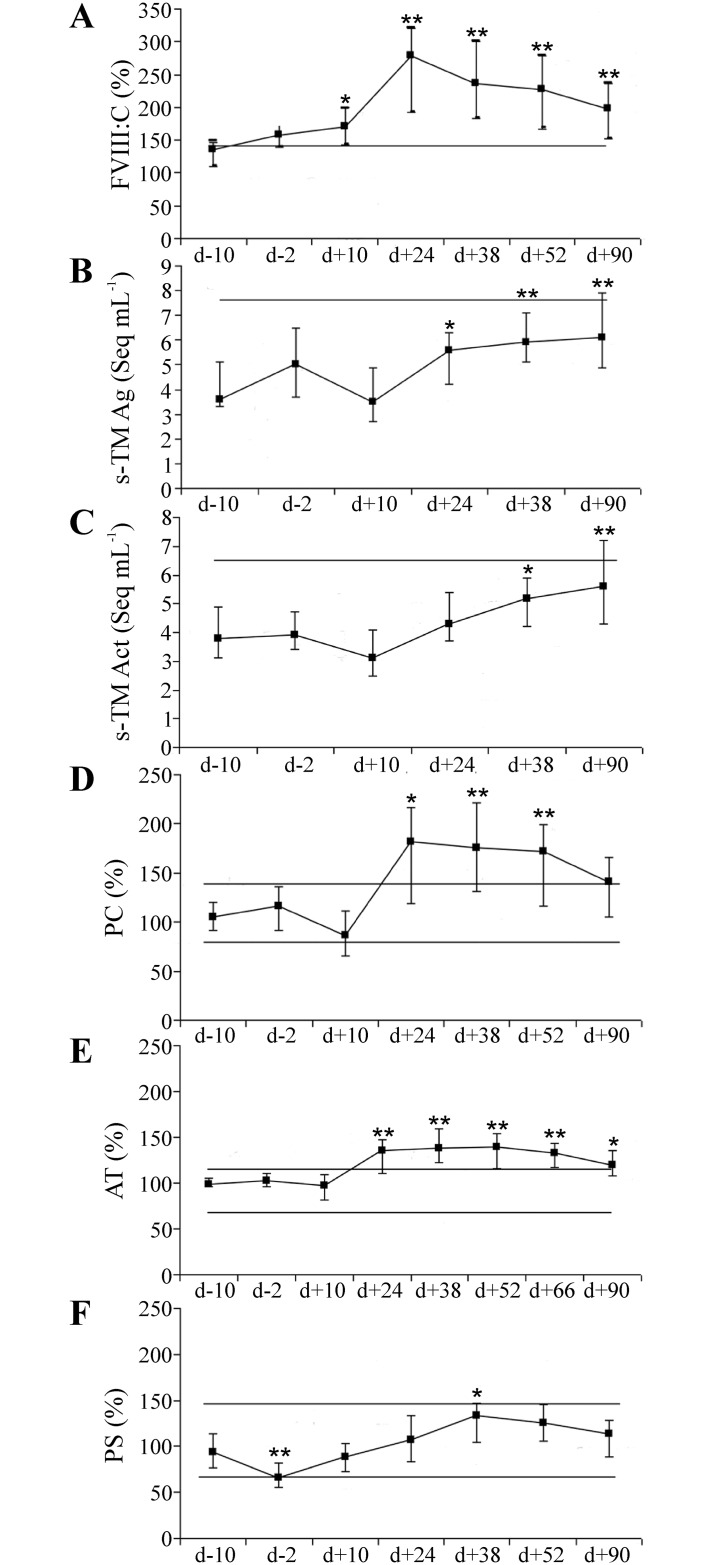
Longitudinal changes of endothelial activation markers and natural anticoagulants in allogenic SCT/graft infusion.Endothelial markers: (A) Factor VIII with coagulant activity (FVIII:C); (B) soluble thrombomodulin antigen (s-TM Ag); (C) soluble thrombomodulin activity (s-TM Act) are shown at 6–7 time points during allogenic SCT treatment. Activities of natural anticoagulants: (D) protein C; (E) antithrombin; and (F) protein S were measured at 7–8 time points. Data points represent median values and error bars—25th and 75th percentiles; comparisons were with baseline values. The horizontal line depicts lower and upper normal reference limits; d = transplantation /graft infusion day; * = p < 0.05; ** = p < 0.001.